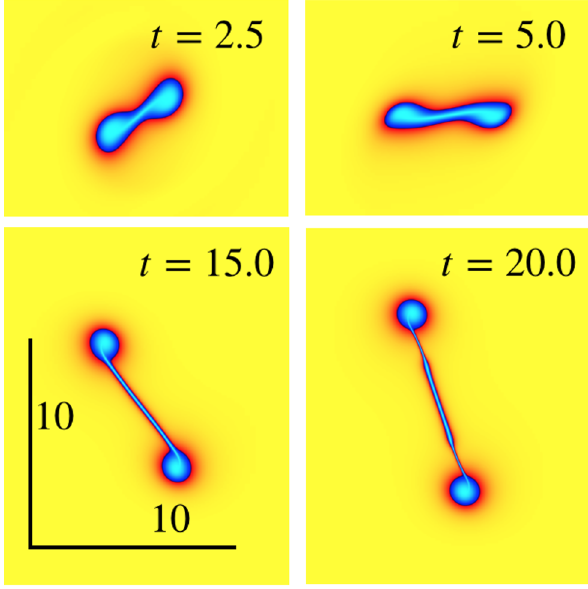
Figure 10 . 6D-B evolution with v = 0 . 45 , a = 0 . 7 , b = 2 . 5